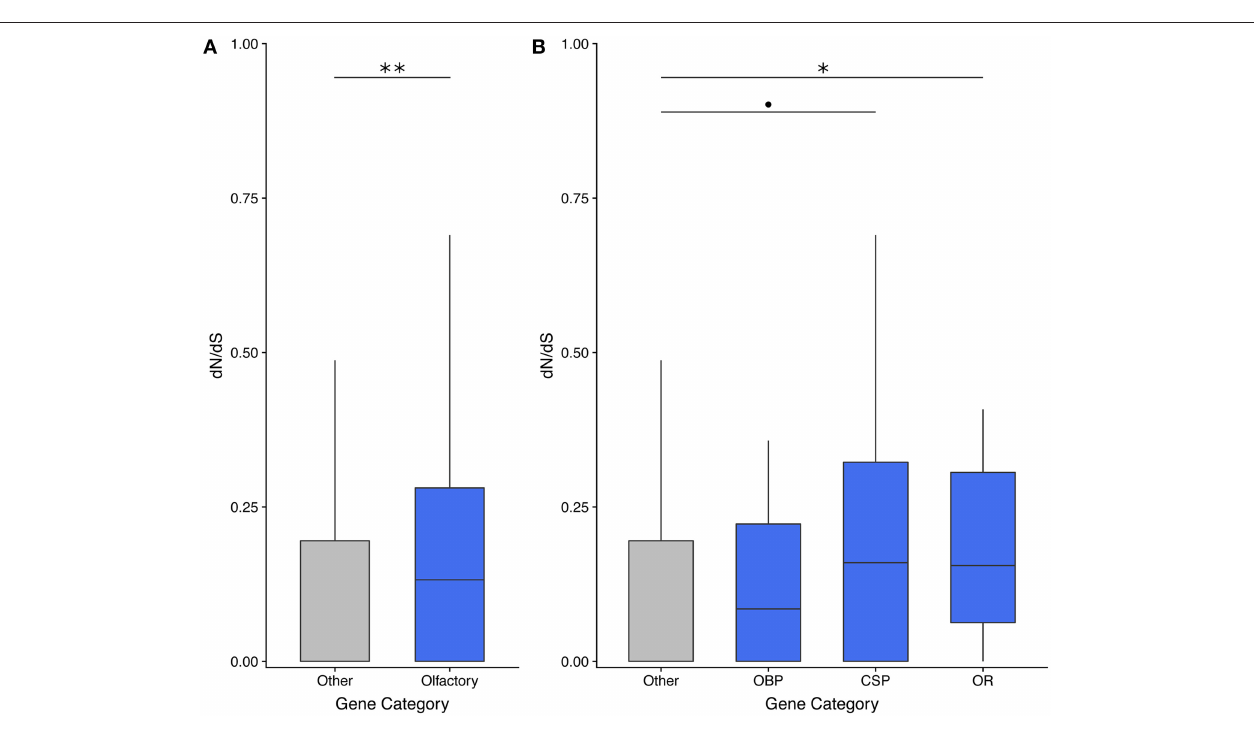
Frontiers in Ecology and Evolution | www.frontiersin.org